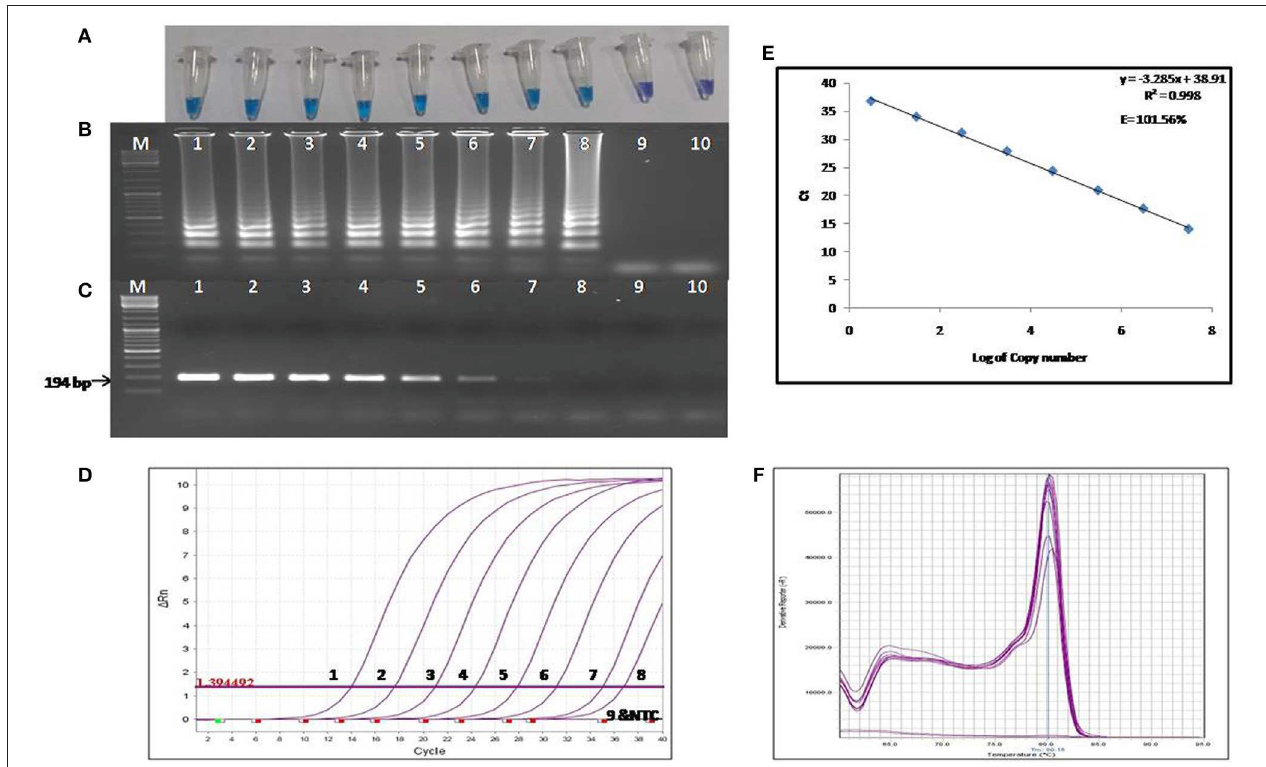
FIGURE 2 | Comparison of the sensitivity of colorimetric LAMP, conventional PCR and qPCR. (A) Results of colorimetric LAMP analysis, (B) Agarose gel electrophoresis of colorimetric LAMP products, (C) Agarose gel electrophoresis of conventional PCR products (D) Results of qPCR Analysis, (E) Standard curve and amplification efficiency, (F) Melting curve analysis. Lane, M: DNA marker; Lanes 1-9: Reaction results from a 10-fold serial dilution of plasmid containing the transposase gene from 3 × 10 7 to 3 × 10 − 1 copies per reaction; Lane 10: Negative control (nuclease free water).